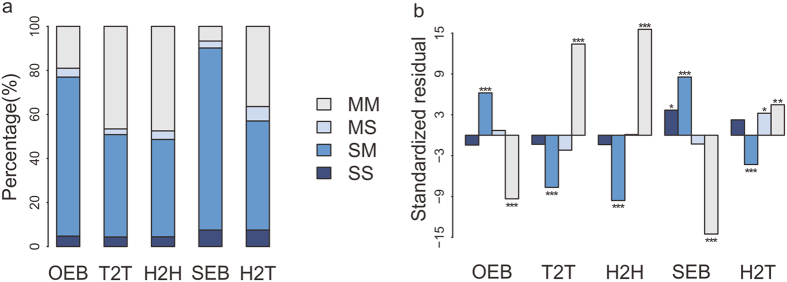
The relationship between alternative splicing pattern and overlapping configuration of human lncRNA-coding pairs.(a) Composition of alternative splicing patterns of human lncRNA-coding pairs in each overlapping configuration. (b) The preference of overlapping configurations for each alternative splicing pattern. The standardized residuals were calculated in a 2 × 2 contingency table and the asterisks on the bar stand for the statistical significances of Chi square test: one for p < 2.5 × 10−3, two for p < 10−5 and three for p < 10−10.